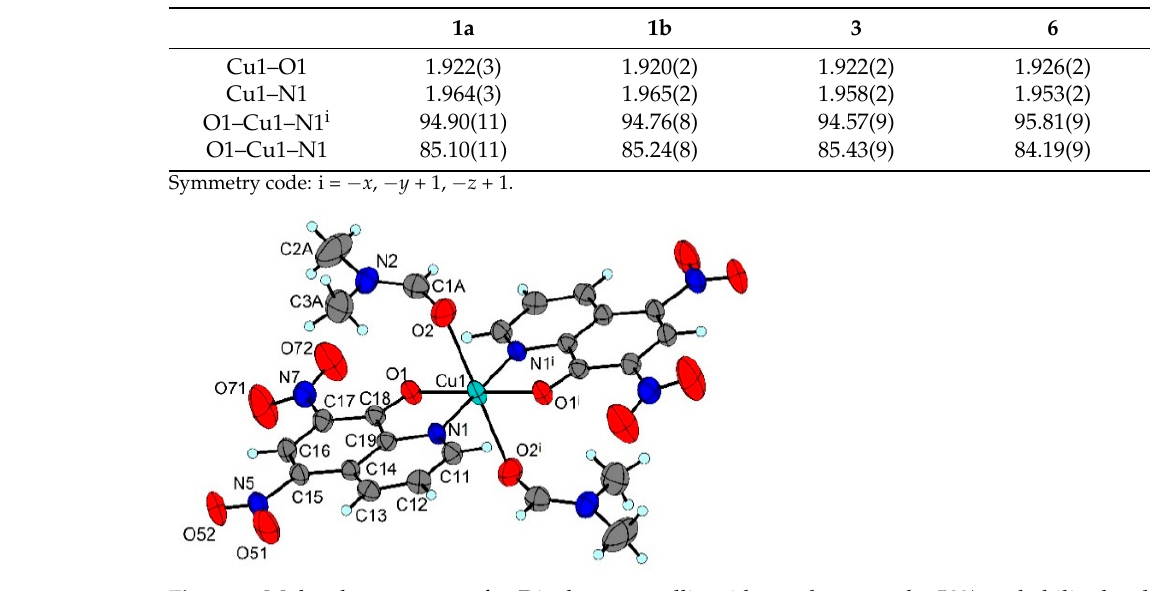
Figure 4. Molecular structure of 5 . Displacement ellipsoids are drawn at the 50% probability level. Only one position of carbon atoms of DMF is shown because of clarity. Symmetry code: i = − x + 1, − y + 1, − z . Table 2. Selected bond lengths [Å] and angles [°] for 5 .